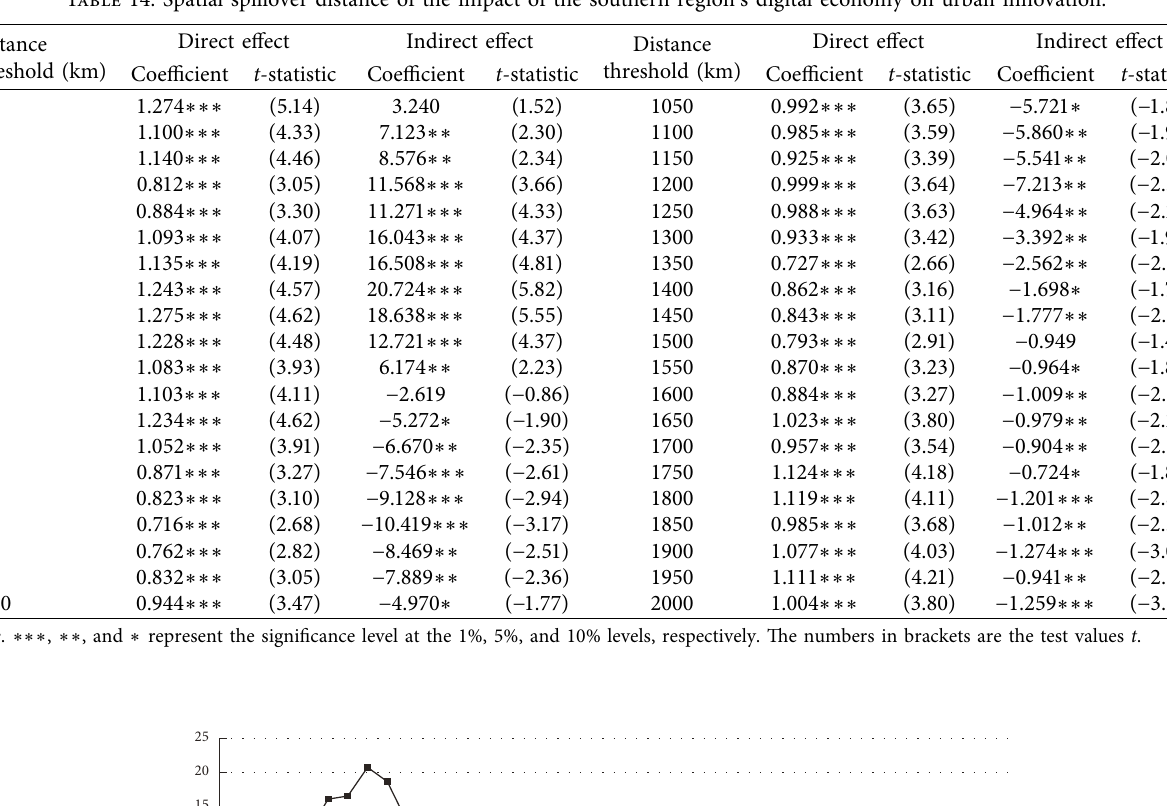
Table 14: Spatial spillover distance of the impact of the southern region’s digital economy on urban